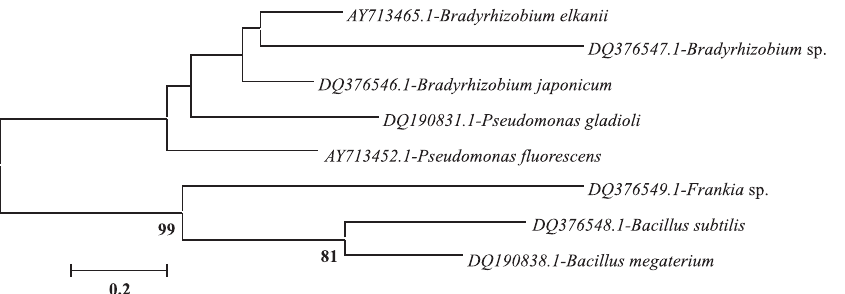
Figura 3. Árvore filogenética construída pelo método da Evolução Mínima (ME) Joining com as oito possíveis espécies de RCPC observadas no